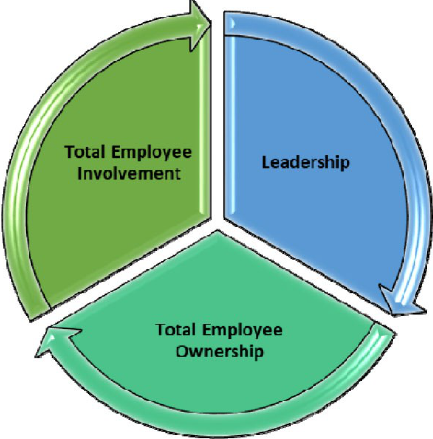
Figure 12. Design Elements layer